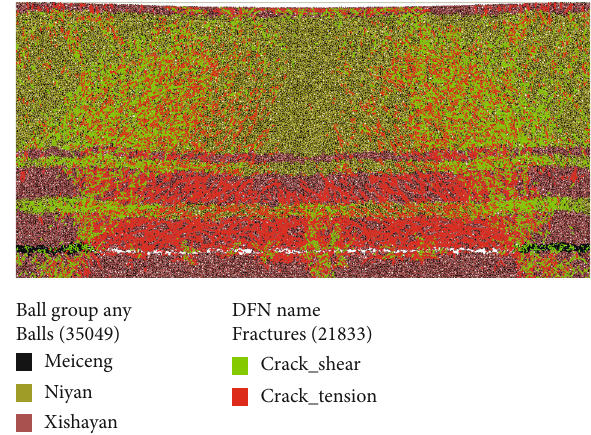
Figure 11: Fracture propagation of bedrock in numerical model.